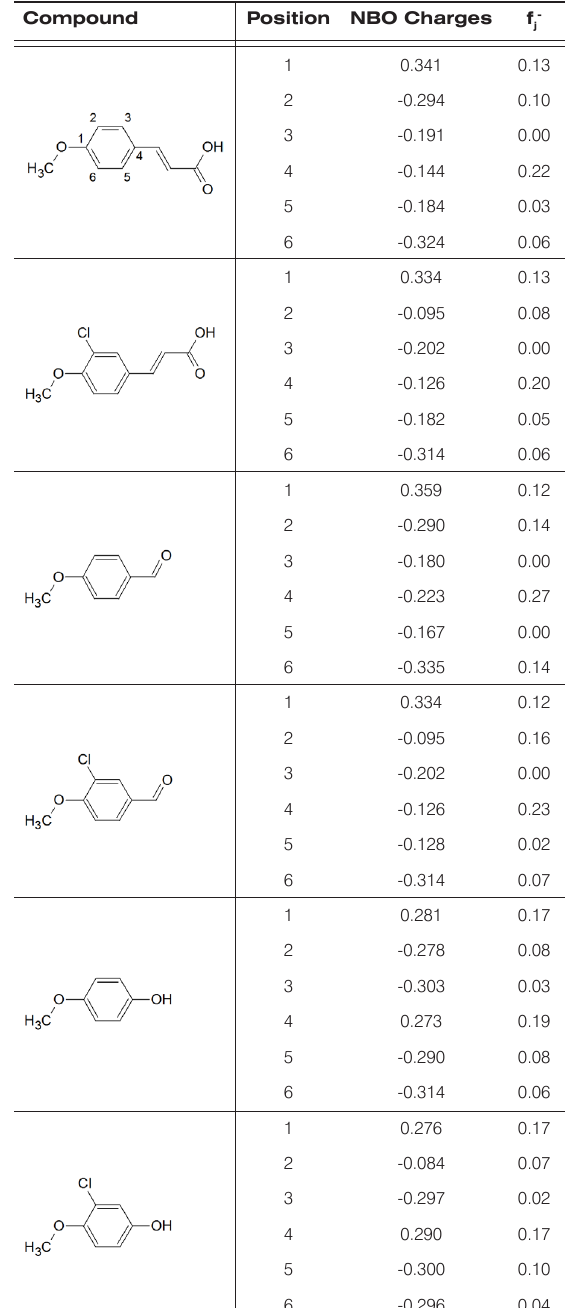
Table 5. NBO charges and Fukui function f j- values in EHMC, 4-MCA, 4-MBA, 4-MP, 3-Cl-4-MCA, 3-Cl-4-MBA and